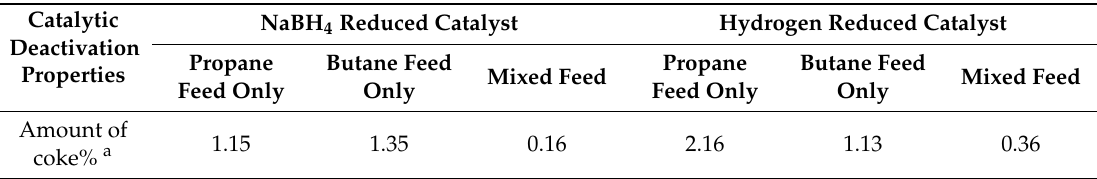
Table 4. Amount of coke deposited on catalysts during para ffi n